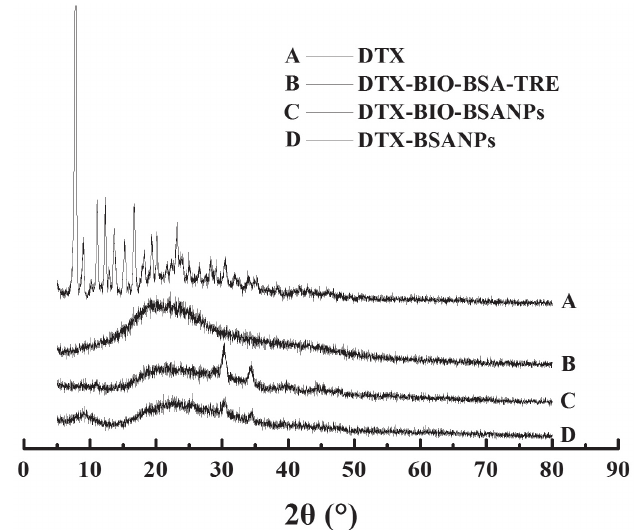
FIGURE 2 - The X-ray diffraction spectrum of docetaxel and freeze-dried DTX-BIO-BSA-NPs. A, docetaxel; B, docetaxel- loaded biodegradable bovine serum albumin nanoparticles with biotin decoration and trehalose. C, docetaxel-loaded biodegradable bovine serum albumin nanoparticles with biotin